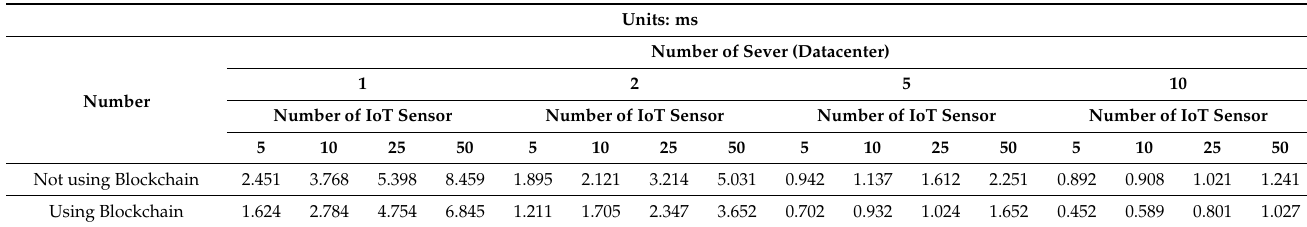
Table 6. Blockchain link creation time comparison.